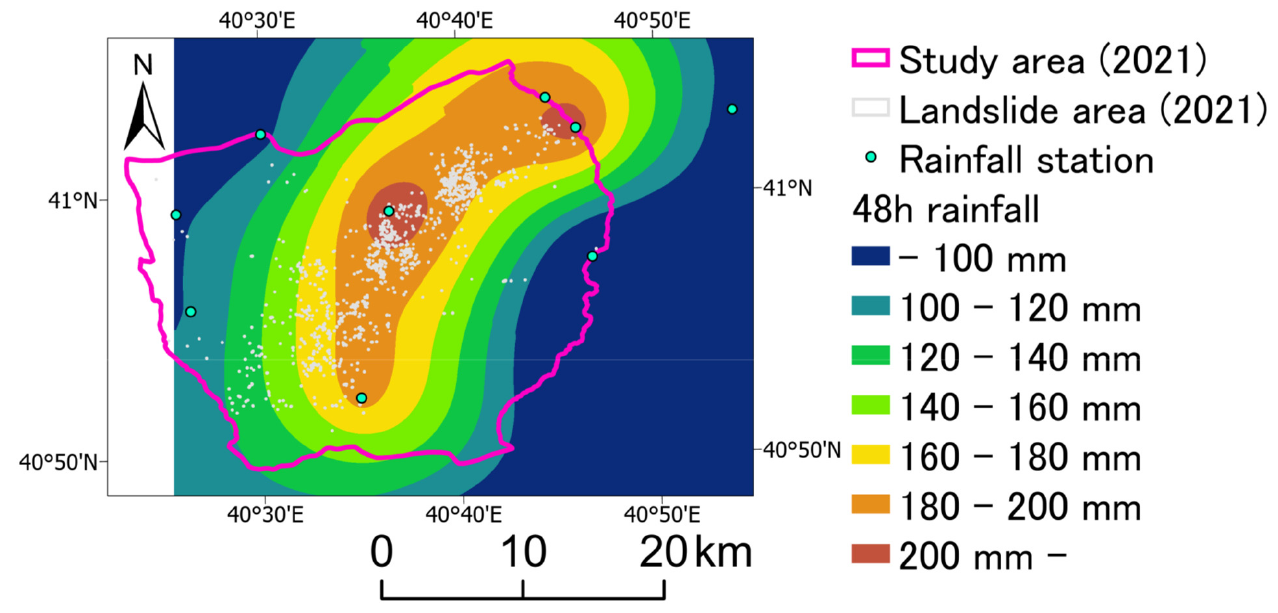
Figure 7. Landslide distribution and two-days rainfall distribution in 2021 (data from TSMS). Table 7. Landslide area ratio and cumulative rainfall in 2021 (data from TSMS). Landslide Area Ratio (%) 48-hr Rainfall